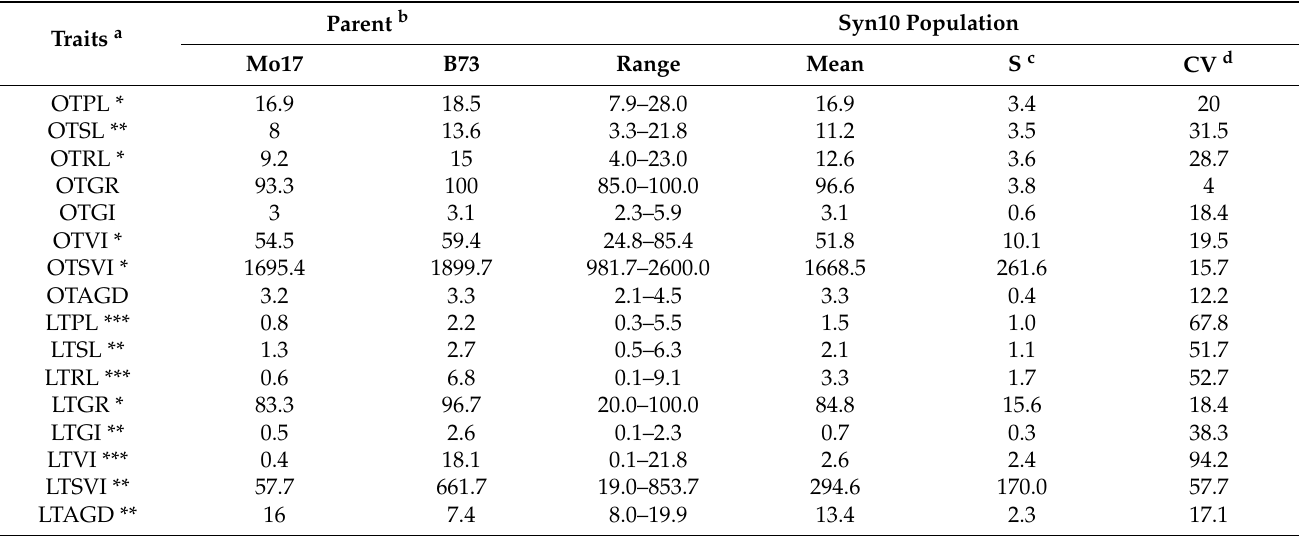
Table 1. Germination-related traits of Syn10 population under optimum or low